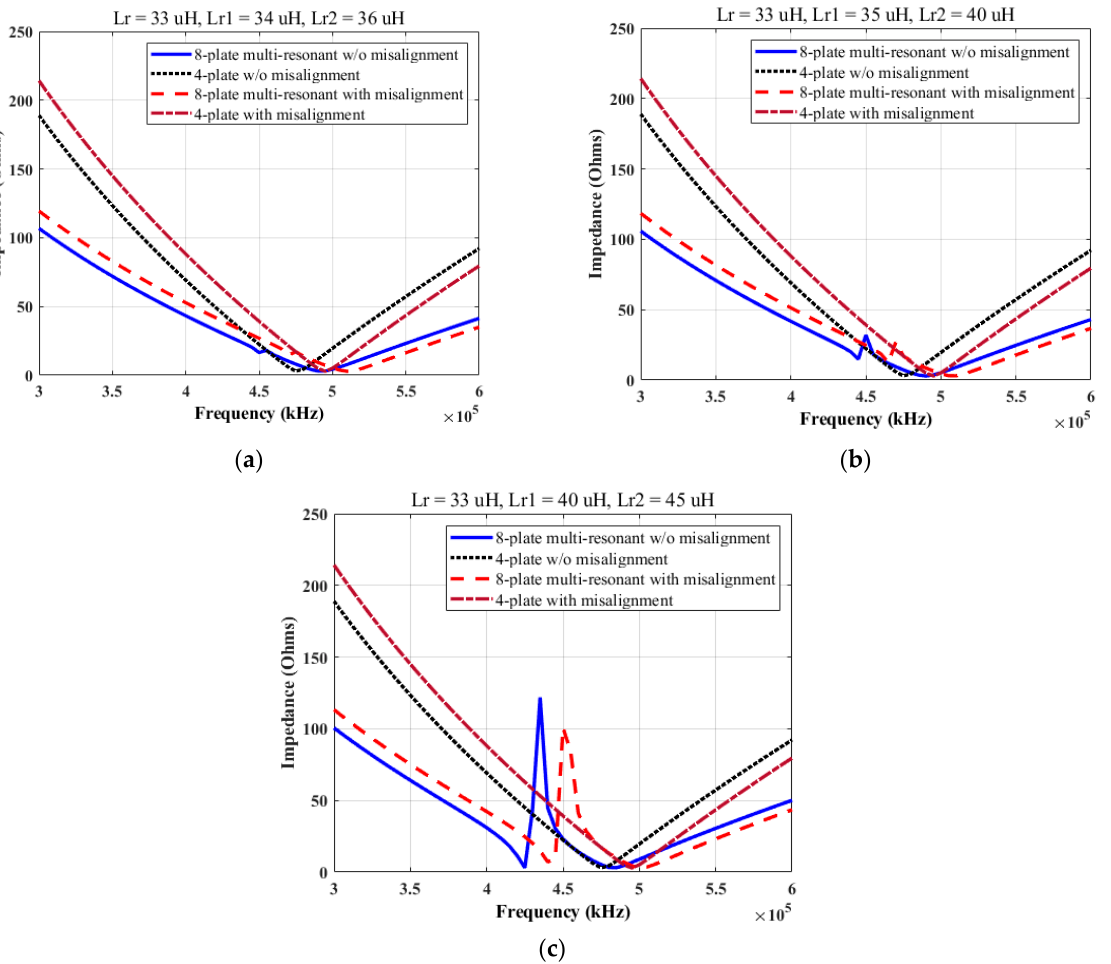
Figure 5. Resonant impedance plots of 4-plate and 8-plate multi-resonant coupling with and without misalignment for three cases; ( a – c ) correspond to the inductor values in Table 1.